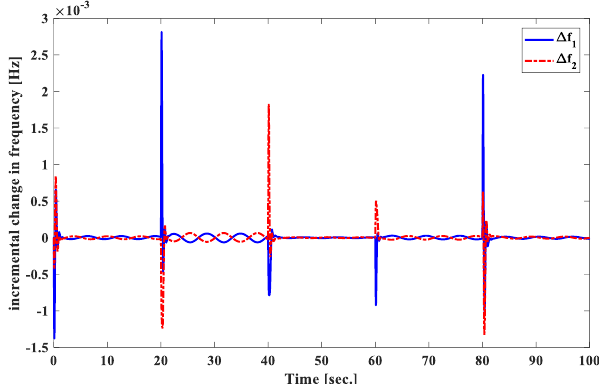
Figure 6. Frequency deviations [Hz] of the control areas 1 and 2 with matched disturbances.